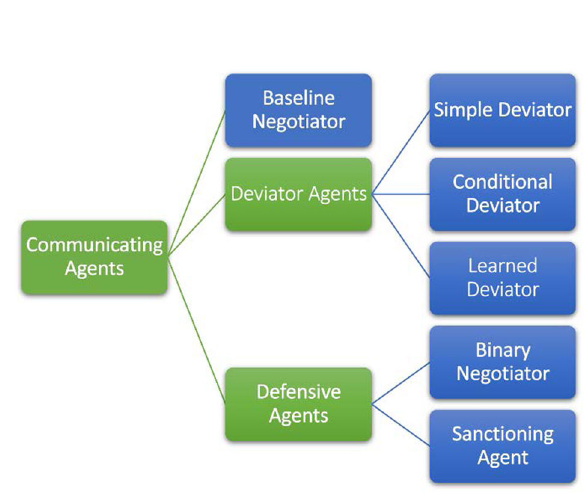
Fig.5|Communicatingagentsconsideredinthiswork. Eachblueblockrelatesto a speci fi c agent algorithm, while each green block relates to a group of agent